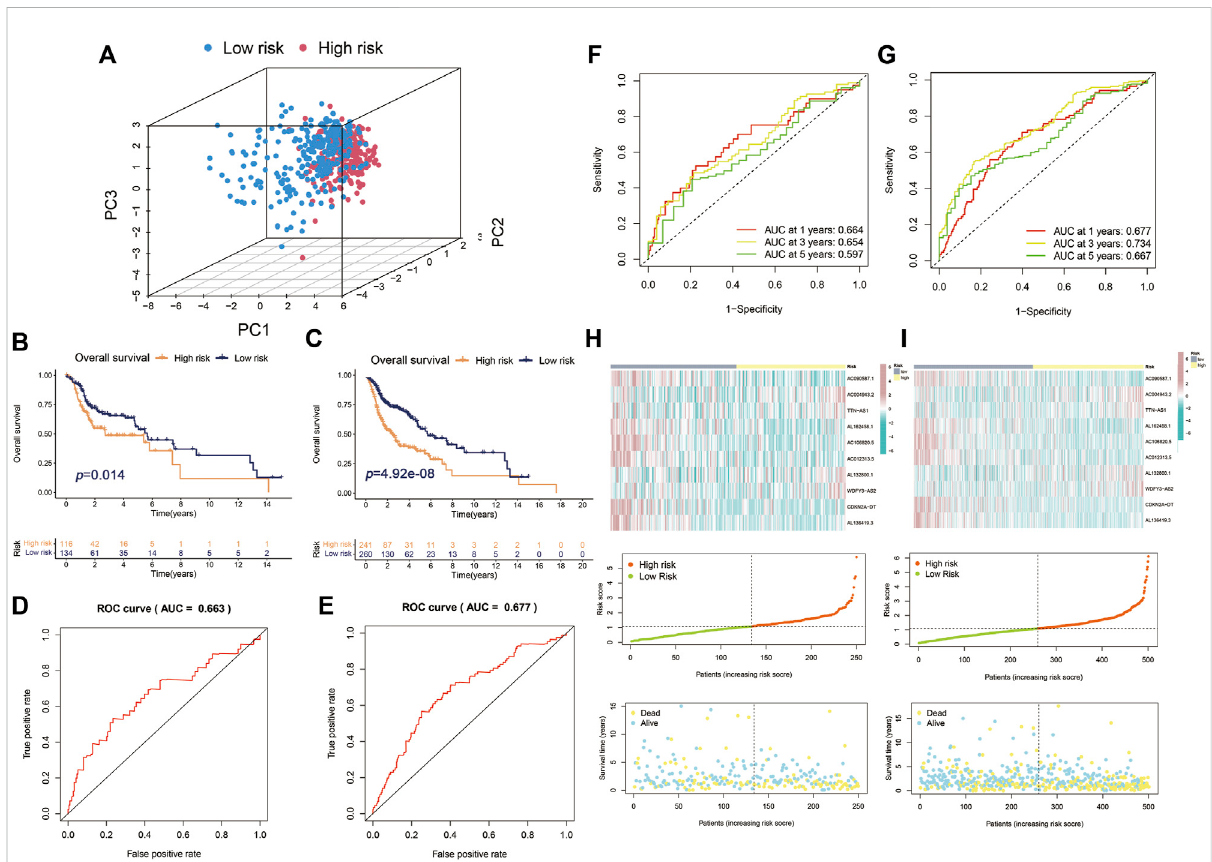
FIGURE 4 Validation of Cupr-RLPS in testing cohort and overall cohort. (A) PCA plots showed the two parts of patients in HNSC separated by risk scores. K – M curves showed the worse OS outcome in the high-risk group in testing cohort (B) and overall cohort (C) . ROC represented for the prognostic signatures in testing cohort (D) and overall cohort (E) . AUC values showed 1, 3, and 5 years ’ predictions in testing cohort (F) and overall cohort (G) , respectively.Theriskscoredistributionplotshowedthepatients ’ distributionofHNSCinhigh-riskandlow-riskgroups;scatterplotdepictedthe relationship between the survival status and the risk scores in high-risk and low-risk groups; heatmaps showed the expression of the 10 Cupr-RLs in high-risk and low-risk group in testing cohort (H) and overall cohort (I) ,